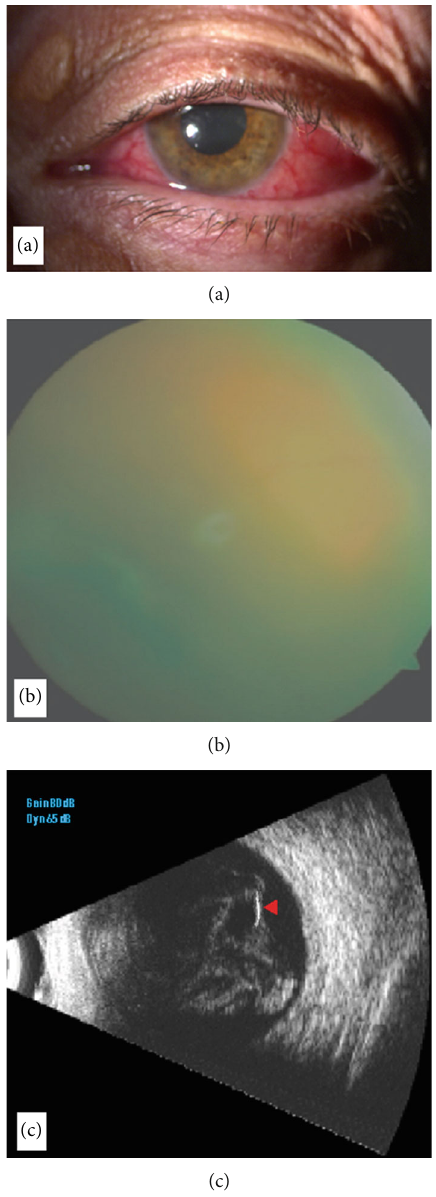
Figure 2: (a) Slit-lamp photograph showing anterior segment reaction. (b) Vitreous cells and severe vitreous haze hinder funduscopy. (c, d) Ocular ultrasonography B-scan reveals the device as a hyperre fl ective area (arrowhead) surrounded by dense hyperre fl ective opacities as dots and membranes in the vitreous